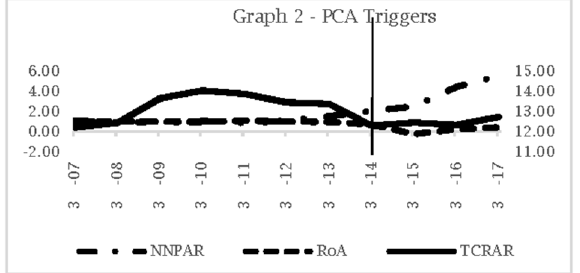
Figure A2. This shows the trends in the NNPAR, RoA, and TCRAR for the last 10 years.